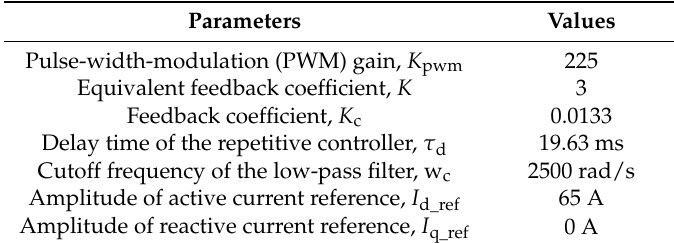
Table 2. Parameters of the Current Control